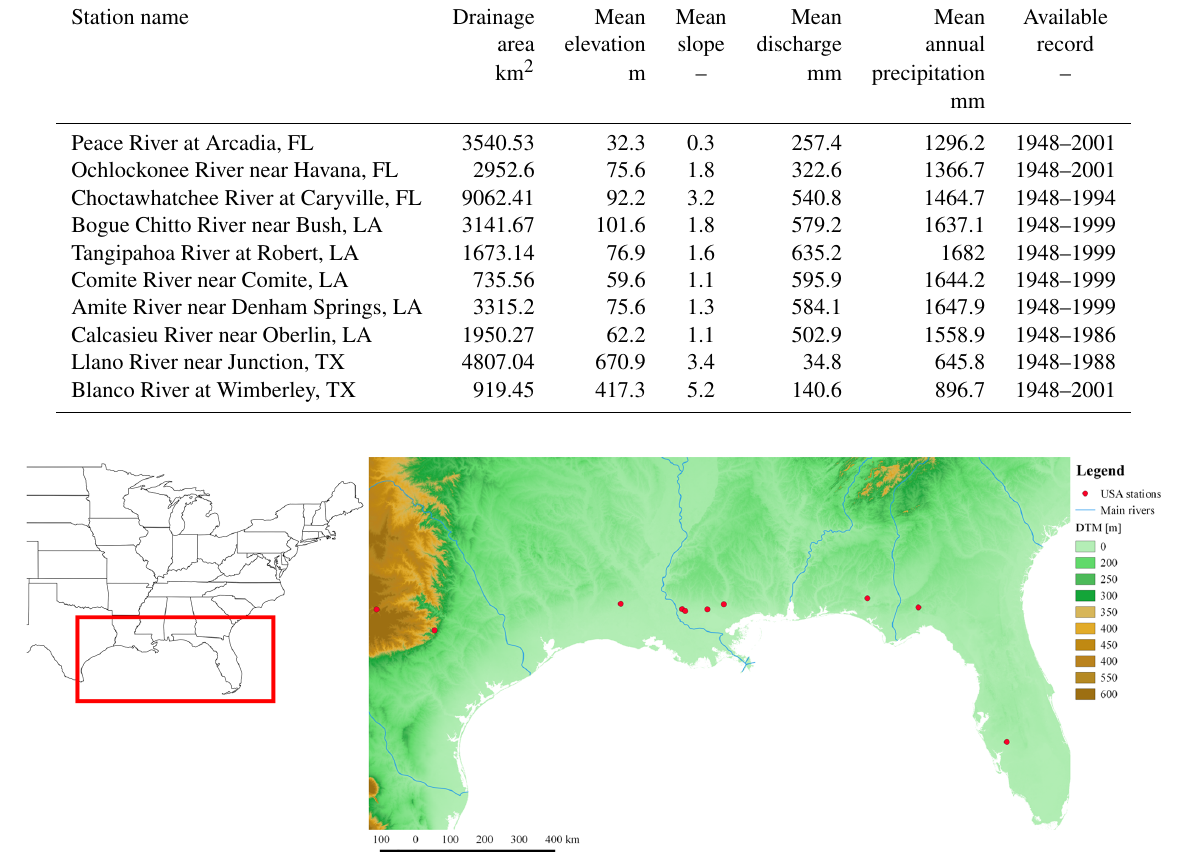
Table 1. US case study area: streamflow gauges and corresponding basin characteristics.